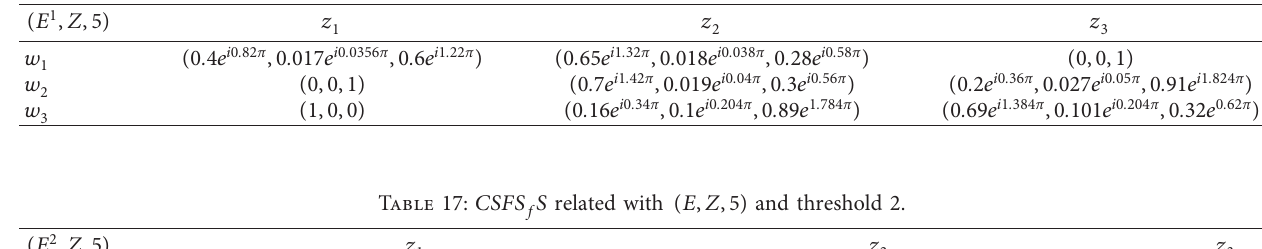
Table 16: CSFS S related with ( E, Z, 5 ) and threshold 1. f